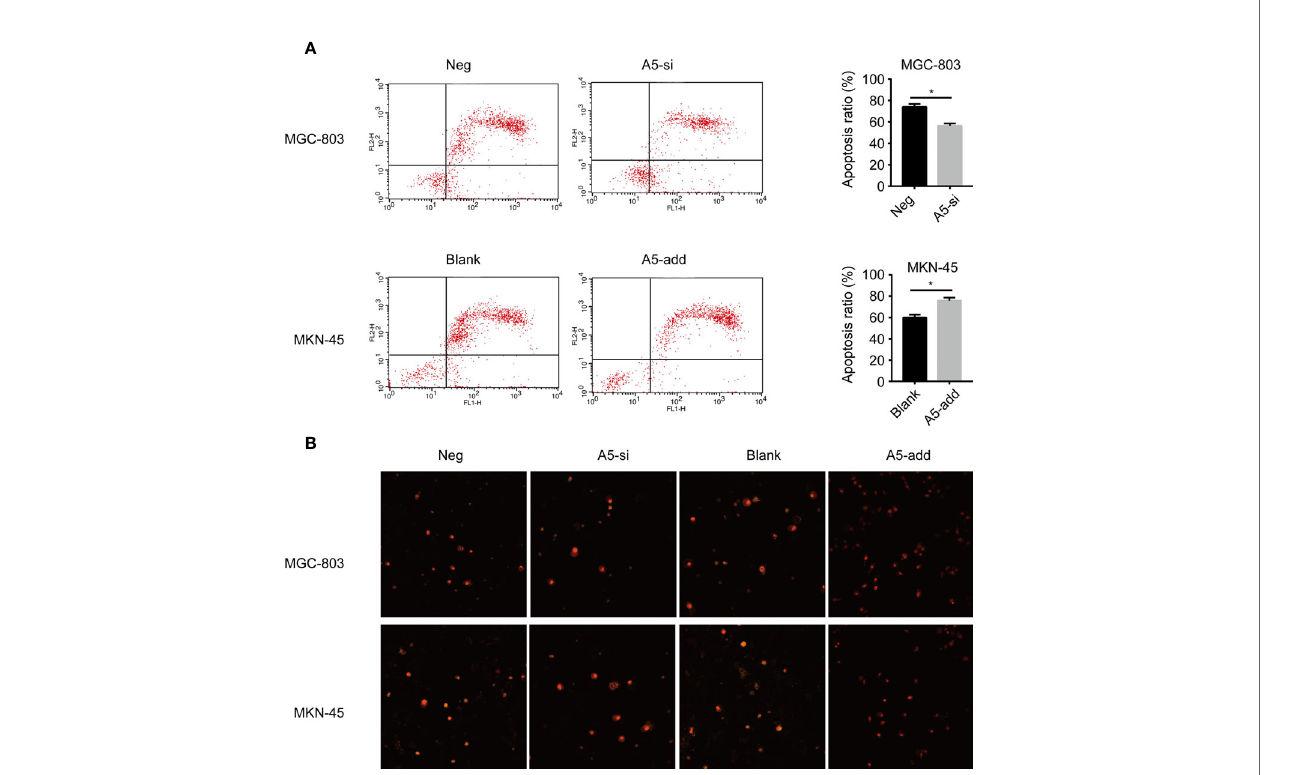
FIGURE 3 | ANXA5 regulated gastric cancer cell death. Flow cytometry (FCM) and PI staining were employed to fi nd out whether ANXA5 could modulate cell death. Apoptosis of A5-si cells decreased while that of the A5-add group increased signi fi cantly (A) . Cells were visualized under fl uorescence microscopy after paraformaldehyde fi xation and staining with PI. The overall cell death of A5-si cells decreased while that of the A5-add group increased signi fi cantly (B) . * P <